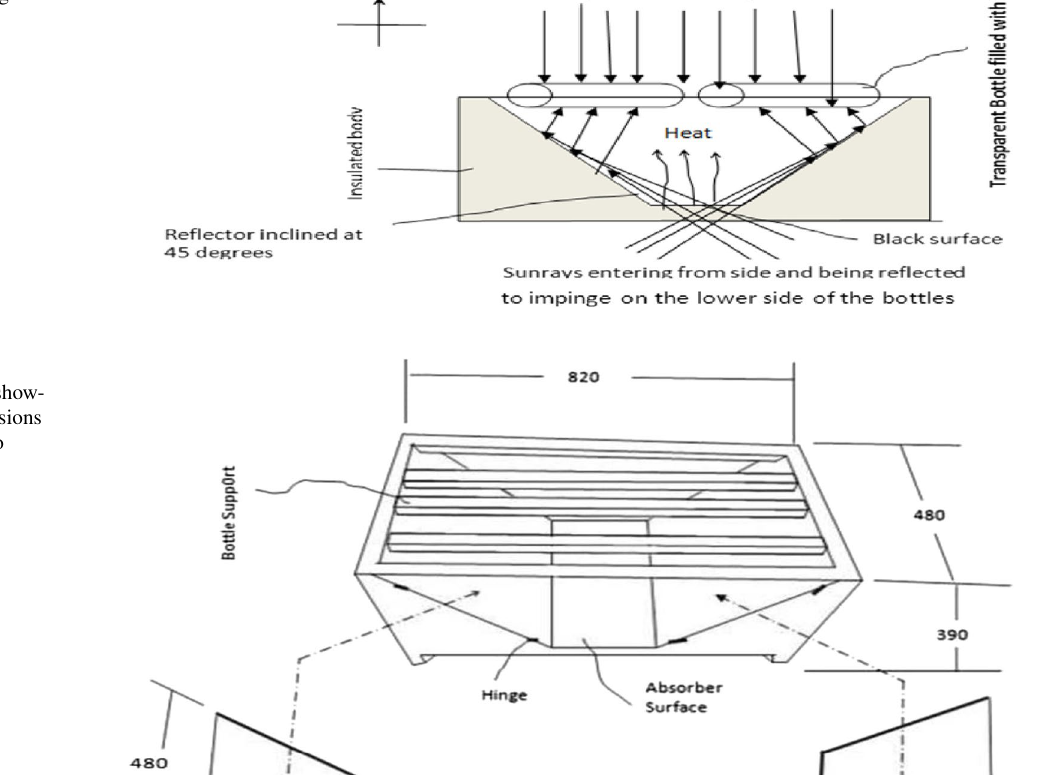
Fig. 1 A schematic diagram of the improved SODIS design